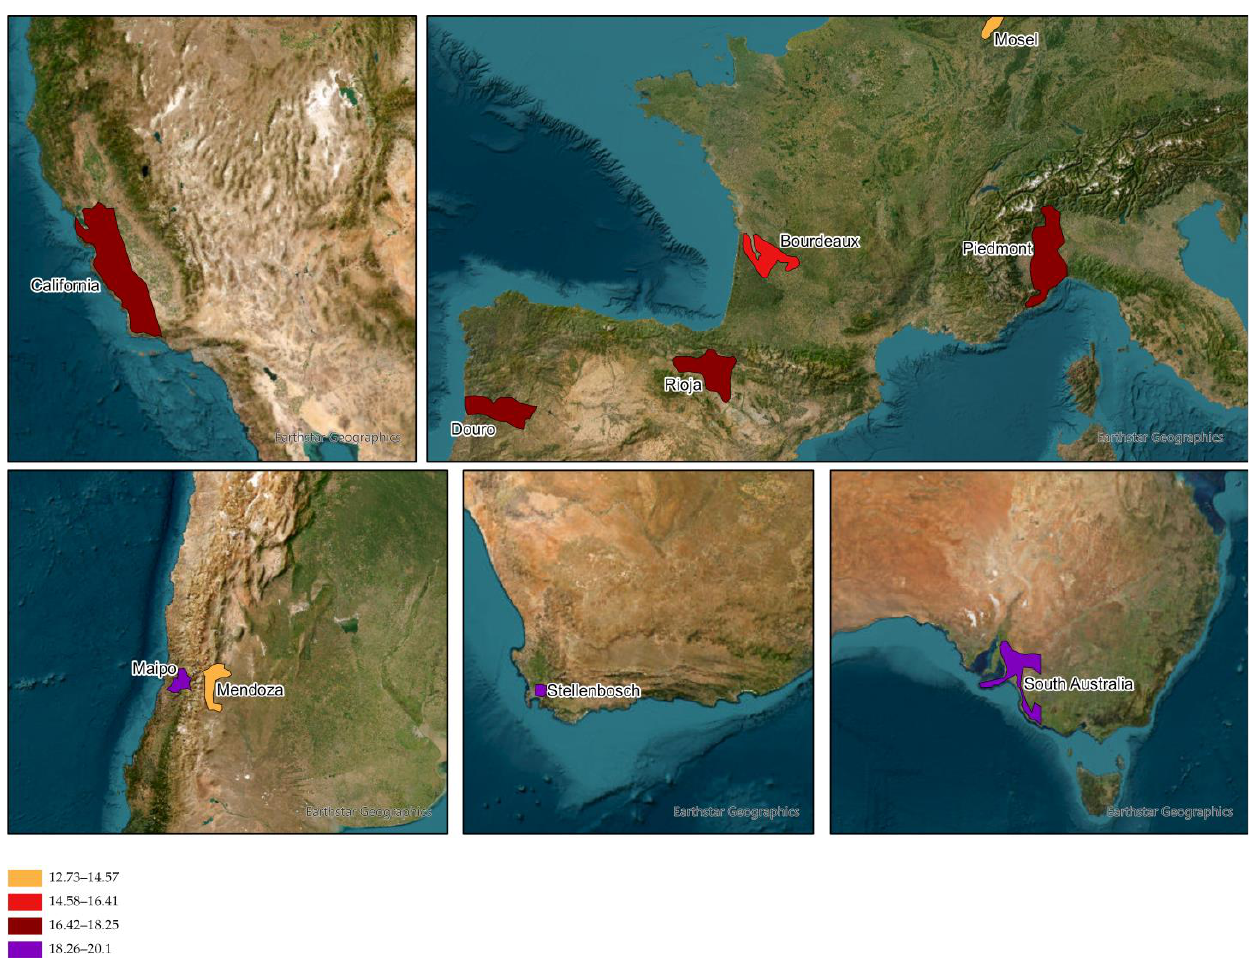
Figure 3. Average annual temperature for selected wine-producing regions for end of century pe- riod (2081–2100) in Celsius. Source: GISS—average annual temperature for 2081–2100 [20], wine-producing regions manually created by the authors, World Imagery by Esri and Earthstar